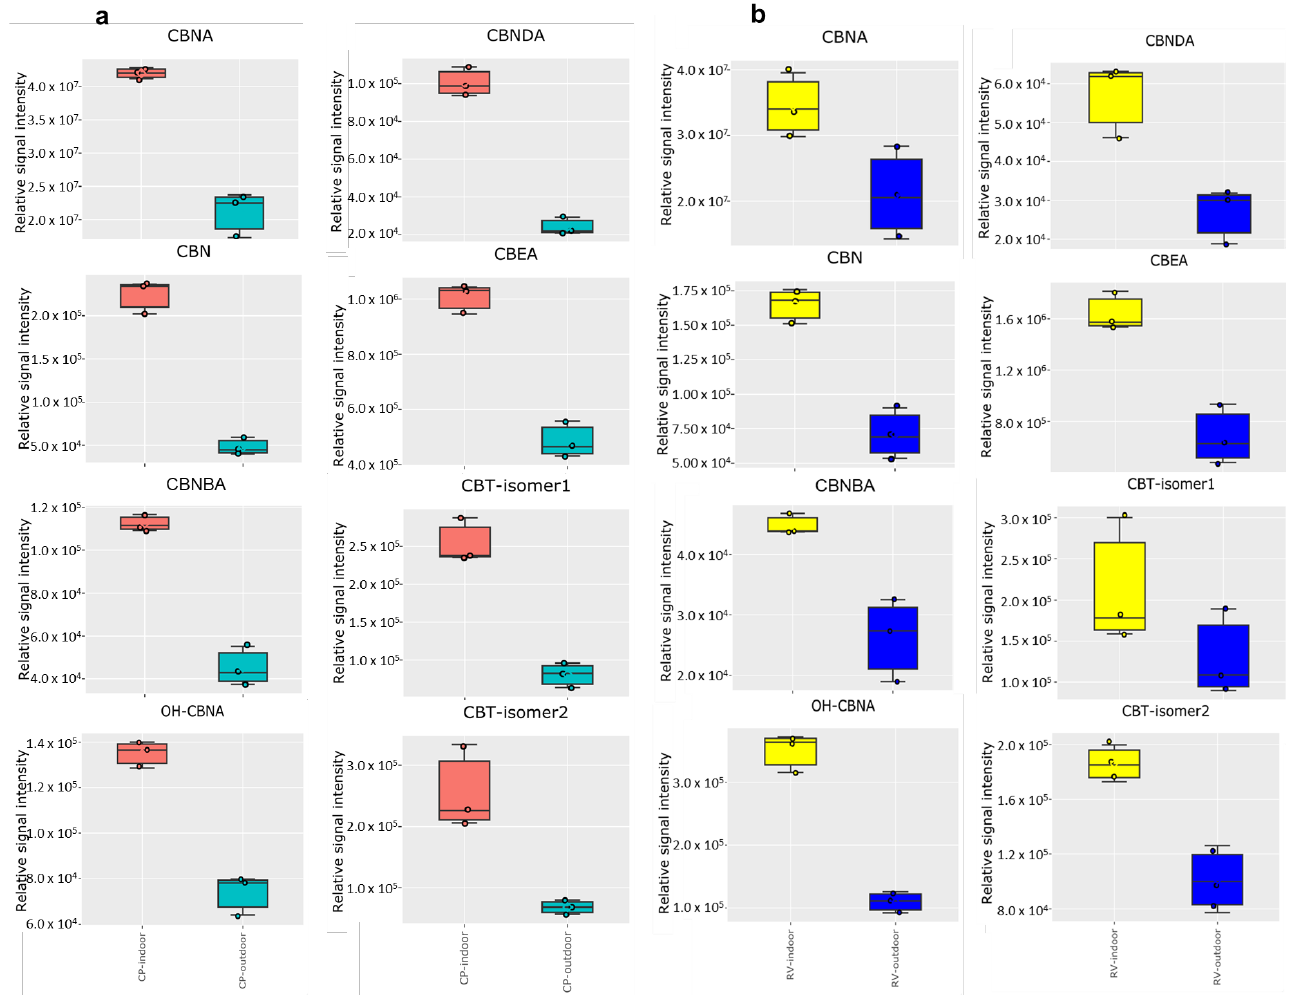
Figure 3. Comparison of the cannabinoids that resulted from oxidation and degradation of the can- cannabinoids CBCA, ∆ 9 -THCA, and CBDA for ( a ) CP-indoor and CP-outdoor; ( b ) RV-indoor and nabinoids CBCA, Δ 9 -THCA, and CBDA for ( a ) CP-indoor and CP-outdoor; ( b ) RV-indoor and RV- RV-outdoor measured by LC-MS analysis (n = 3 independent samples per outdoor measured by LC-MS analysis (n = 3 independent samples per group).